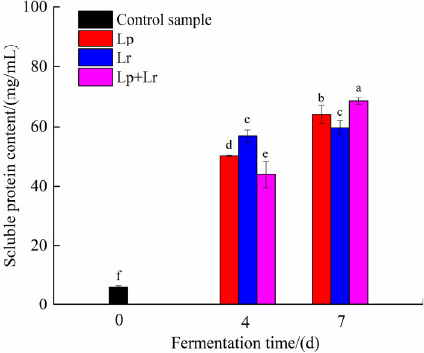
Figure 5. Soluble protein content of edible grass during fermentation. Different superscript letters in the columns indicate significant difference ( p < 0.05). Abbreviations: Lp, Lactobacillus plantarum ; Lr, Lactobacillus rhamnosus ; Lp+Lr, mixture of Lactobacillus plantarum and Lactobacillus rhamnosus .